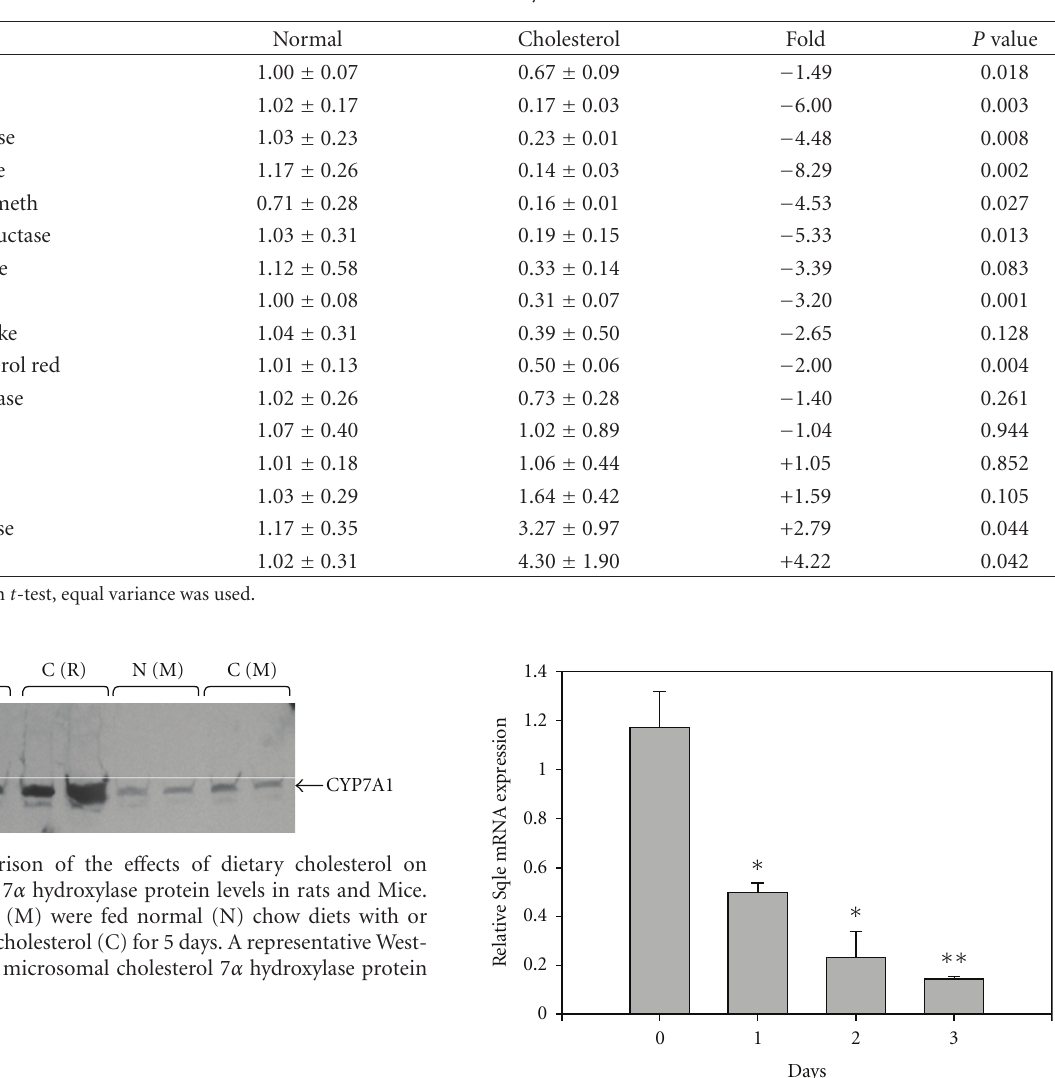
Table 5: RT-PCR analysis.